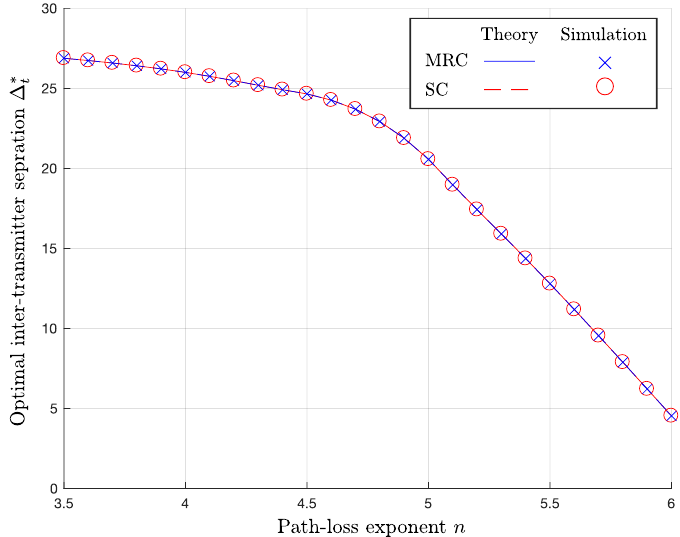
n , when γ th = 10 − 3 , t versus path-loss exponent